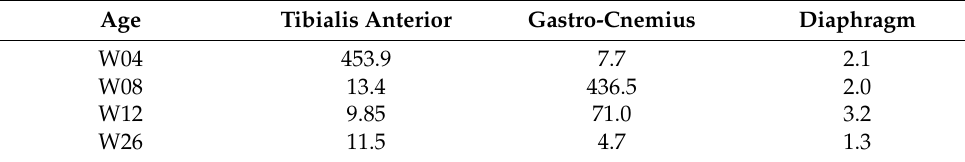
Table 1. SMIT fold changes in skeletal muscles of mdx mice relative to controls. Age Tibialis Anterior Gastro-Cnemius Diaphragm W04 453.9 7.7 2.1 W08 13.4 436.5 2.0 W12